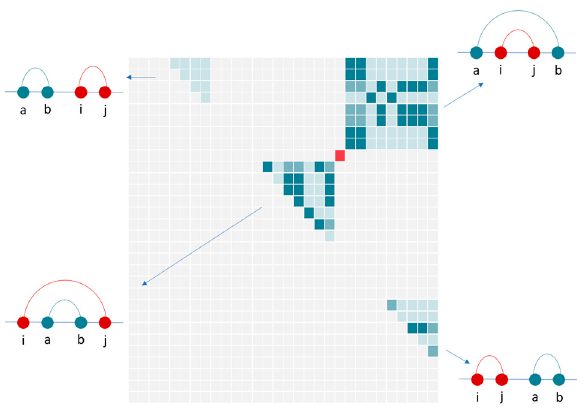
Figure 4. Select the action space left after base pairing (i, j) . In the figure, each box represents one pair of residues, and sequence directions is from left to right and top to down. The red square represents the currently selected base pairing, noted as (i, j), the blue area represents the remaining base pairing area that can be formed, referred to as (a, b); the dark blue inside represents standard base pairing, and the light blue represents Wobble base pairing. The case of pseudoknots is not considered here.